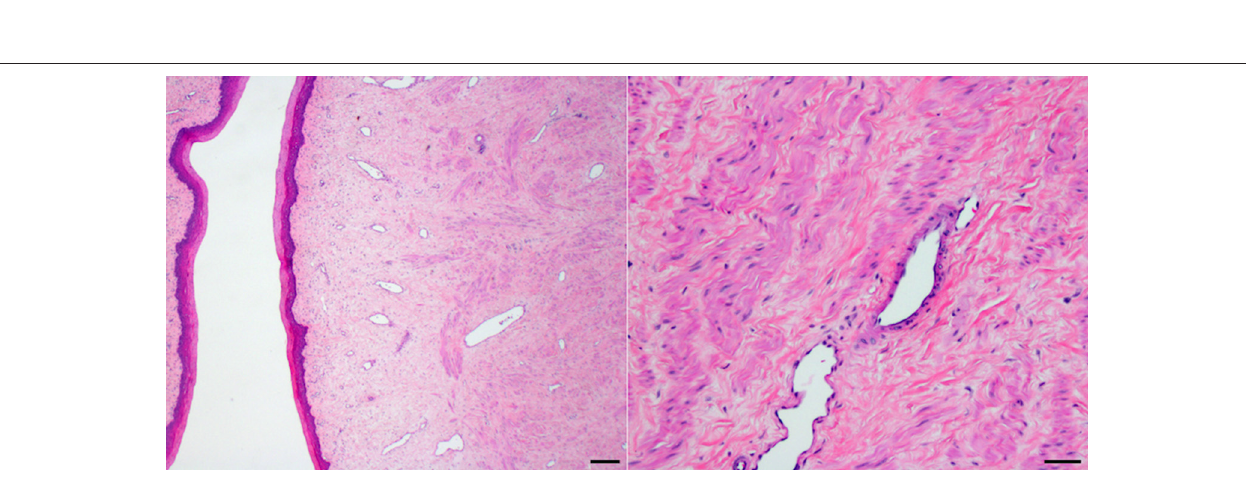
FIGURE 3 | Vaginal fibroleiomyoma (H&E stain; bar = 200 microns and 20 microns).